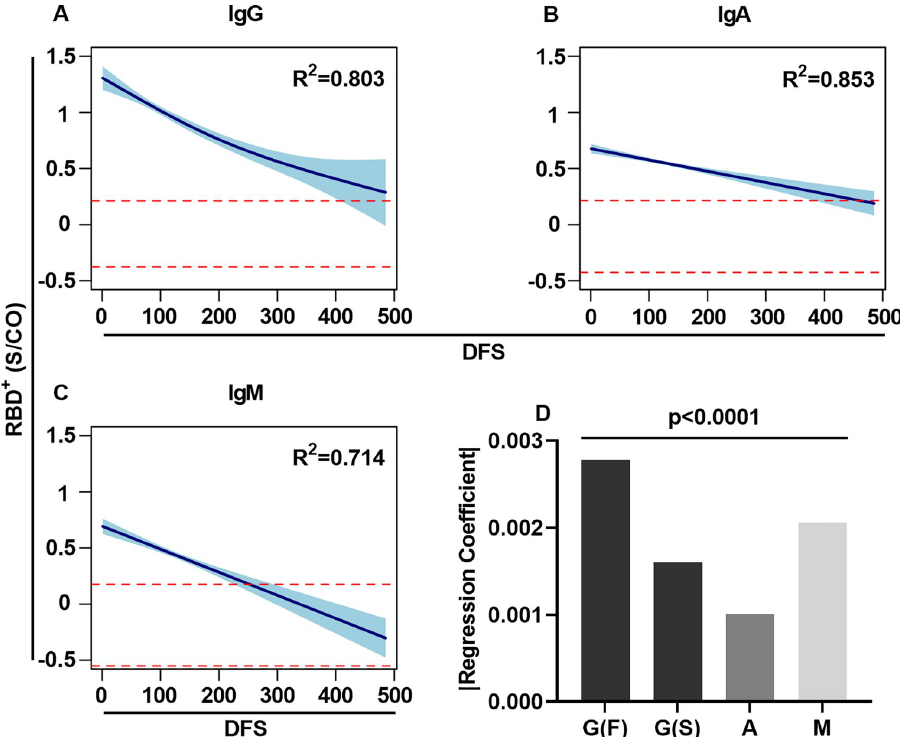
Fig 3. RBD + antibody longitudinal kinetics over the period of 14 months. GAMM analysis of RBD + antibody longitudinal kinetics for IgG (A), IgA (B) and IgM (C). The y-axis in log 10 and the x-axis show days following symptoms (DFS). Dashed red lines represent the maximum and minimum range of the antibody levels, as measured in negative control samples (n = 27). GAMM analysis was used to determine the regression coefficient for each isotype. Negative regression coefficients (i.e., slope) of a two-phase decay or a linear decay were determined for IgG, IgA, and IgM, indicating that all isotypes decayed over the 14-month period. The 95% CI is plotted in turquoise. (D) Bar plot showing the multiple comparison analysis of the regression coefficients obtained for IgG in its fast (F) and slow (S) decay rate phases and the decay rate of IgA, and IgM. For all graphs, p values, R 2 , effective degrees of freedom (edf) and slopes are shown in S2 Table. p values < 0.05 were considered